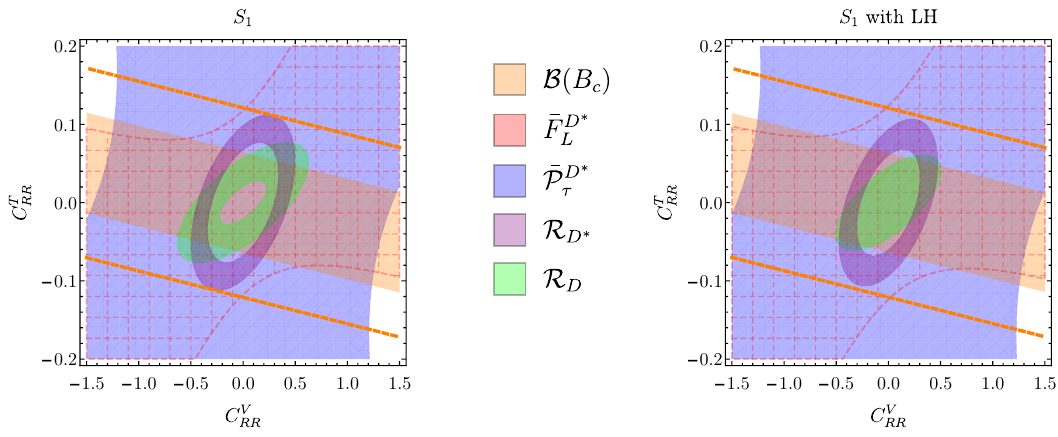
Figure 7 . Fit-independent plot of Scenario 7 , showing the regions allowed at 1 (cid:27) . On the left panel only the RHN Wilson coe(cid:14)cients are considered ( Scenario 7a ), whereas on the right panel we set the LHN Wilson coe(cid:14)cients entering in Scenario 7b to their best (cid:12)t values. The dashed orange line corresponds to the more relaxed bound B ( B c ! (cid:28) (cid:22) (cid:23) ) (cid:20) 30%, and the red grid shows the parameter space consistent with the experimental measurement of (cid:22) F D (cid:3) at 2 (cid:27) L